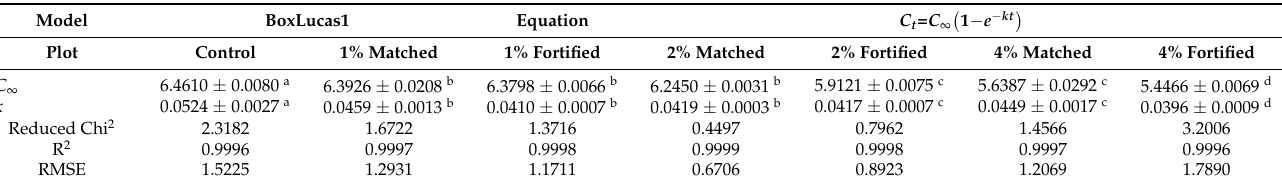
Table 1. Modeling parameters of in vitro digestion